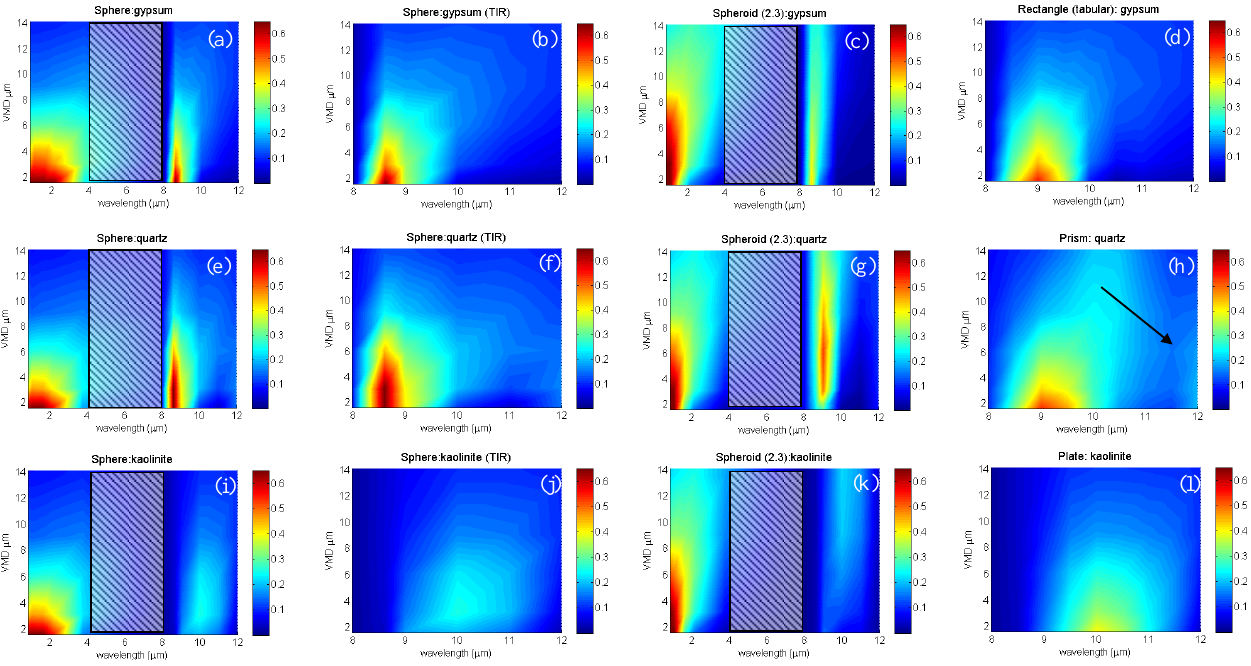
Figure 7 Surface plots depicting MEE distributions (units are in m 2 g -1 ) for several key minerals as functions of particle chemistry (rows), particle morphology (columns – note the 2 nd and 4 th columns are only for IR wavelengths), and particle size (VMD) and wavelength λ (vertical and horizontal axes, respectively). Columns 2 and 4 compare MEE for spheres and angular particles in the thermal IR (TIR). Gray hatched boxes denote data gap between =3.75-8 m. Note the changes in MEE distributions (hot-spots) when dust parameters are perturbed.